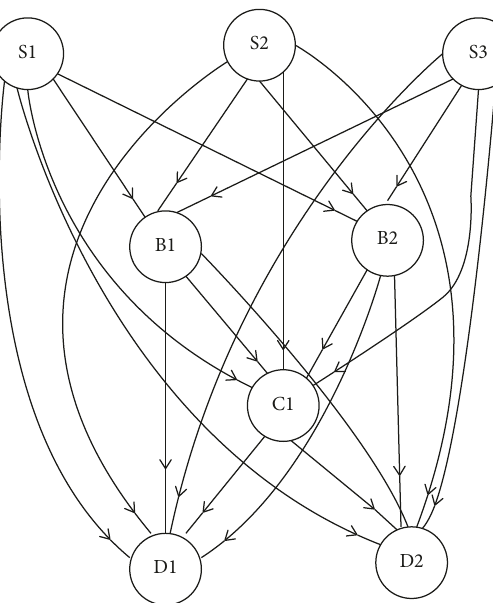
Figure 2: Graphical representation of the numerical